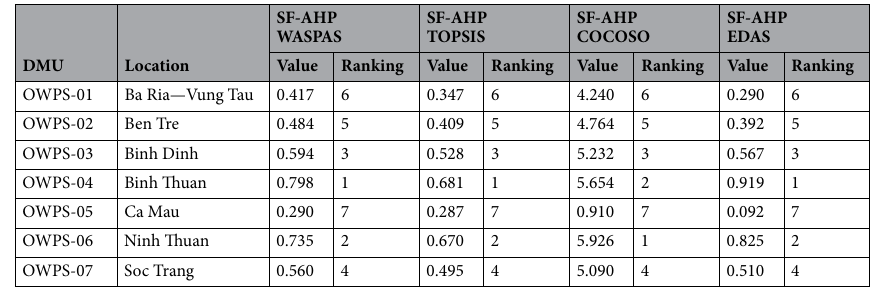
Table 15. The comparison of four kinds of ranking methods.